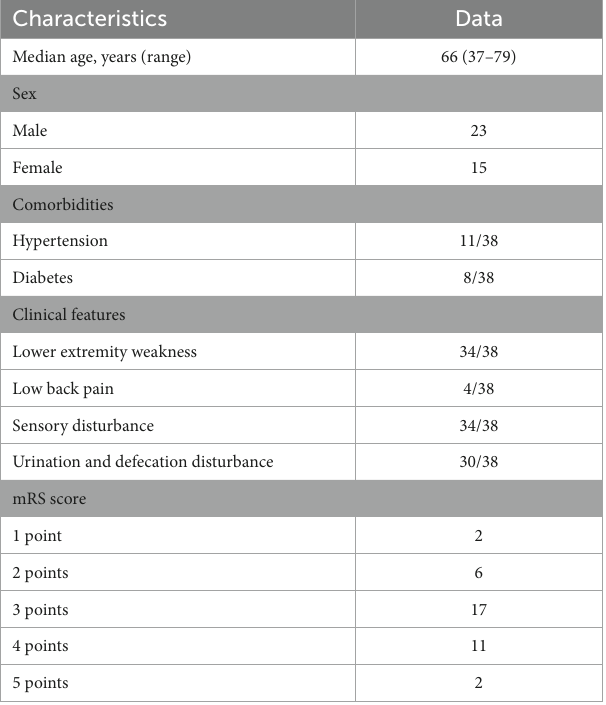
TABLE 1 Demographic and clinical features of lumbosacral SDAVF patients ( n = 38). Characteristics